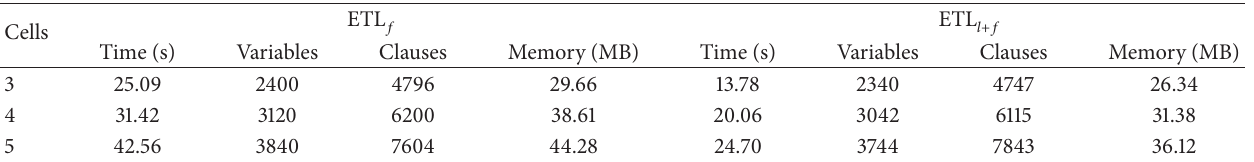
Table 4: Comparison of ETL 𝑓 and ETL 𝑙+𝑓 with liveness